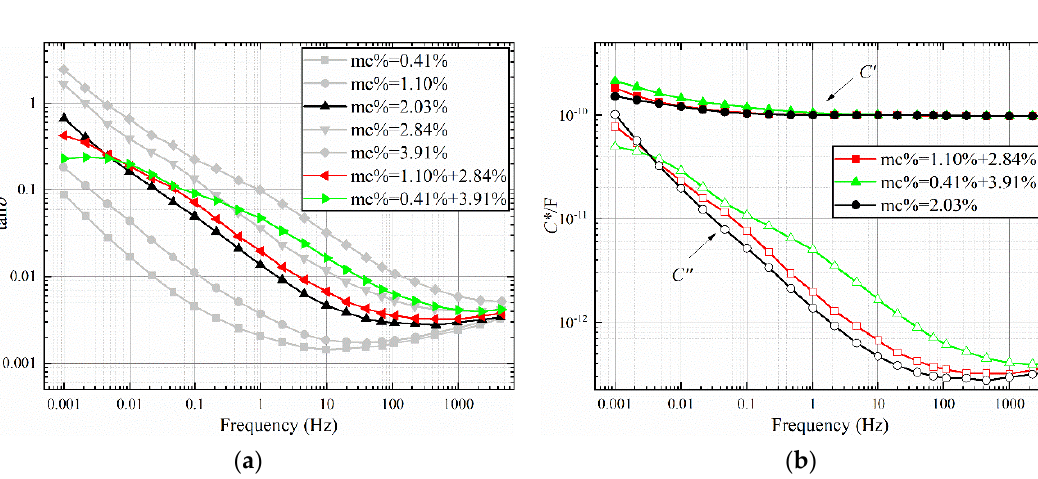
Figure 6. Frequency Domain Spectroscopy (FDS) characteristic curve with an average water content of 2%. ( a ) tan δ - f , ( b ) C *- f .